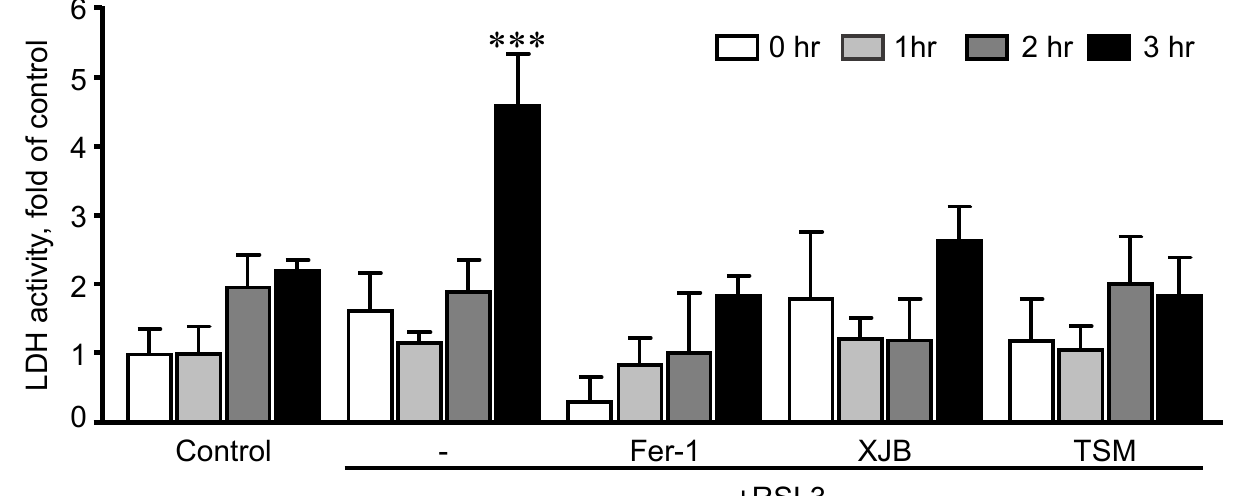
Figure 2. Time-dependence analysis of RSL3-induced cell death in H9c2 cells. LDH activity as a marker of cell death was measured in the culture medium containing H9c2 cells that were exposed to 0.5 µ M RSL3 for 1, 2, and 3 h, in the presence and absence of 1 µ M Fer-1, 0.2 µ M XJB, or 0.6 µ M TSM. Data were normalized to the control for each time-point and presented as a fold increase. *** p < 0.001 vs. control. n = 3 per group.